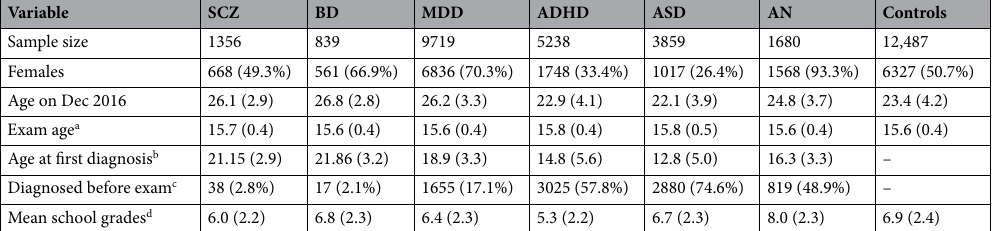
Table 1. Sample characteristics. The values represent either frequency (proportion) if categorical variable or mean (SD) if continuous variable. a Exam age is the age of the individuals when they sat for the exit exam. b The age at first diagnosis was calculated based on the first time the diagnosis was recorded in the register. c The date of first diagnosis and the date of exit exam were compared to identify if the individual has received the diagnosis before they sat for the exam. d The mean value was calculated across all the grades: Danish written, oral and grammar and English oral and mathematics written and oral (if sat for the exam before on or before 2006) or problem solving (if sat for the exam after 2006); The lowest and highest mean values observed were − 1.7 and 12.